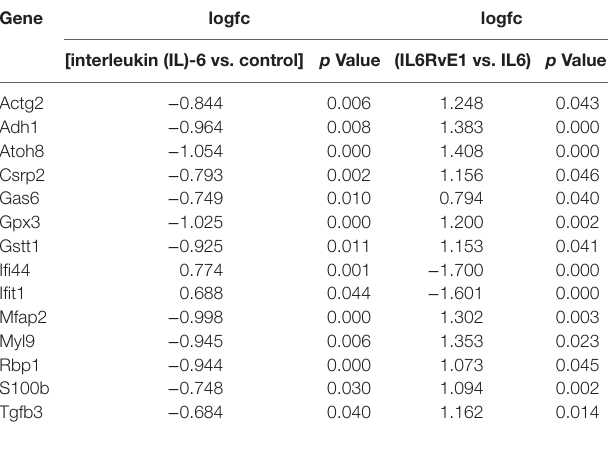
TaBle 1 | List of genes differentially regulated by RvE1 treatment.